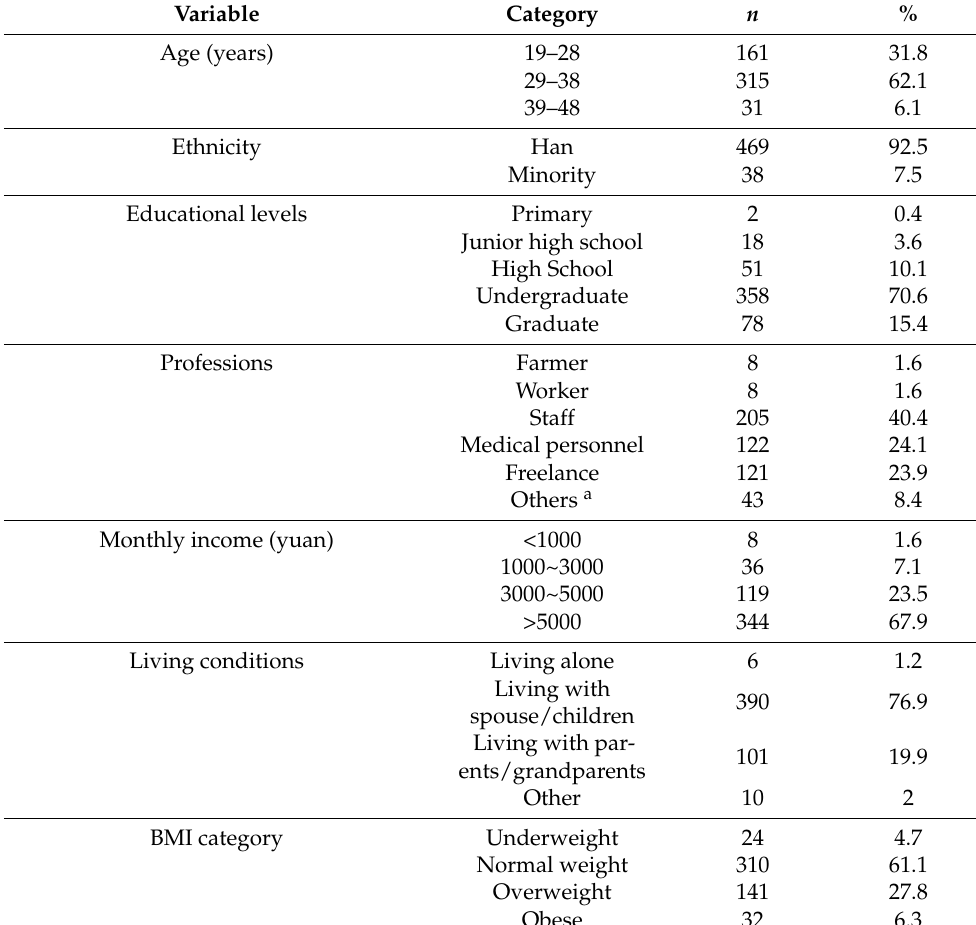
Table 1. Sociodemographic Characteristics of the Participants ( n = 507).